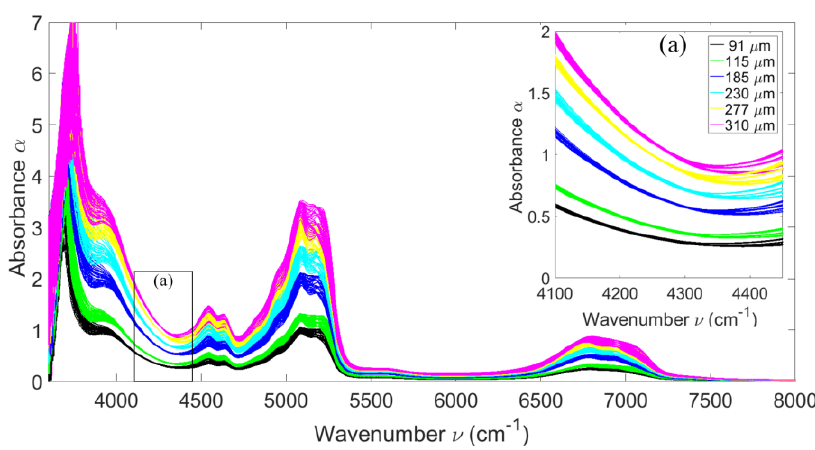
Figure 2. Absorbance spectra of all calibration measurements over the wavenumber. Spectra are color coded with respect to the film thickness 𝛿 and contain all T and c variations. (a) Enlarged section between 4100 cm −1 and 4450 cm −1 .